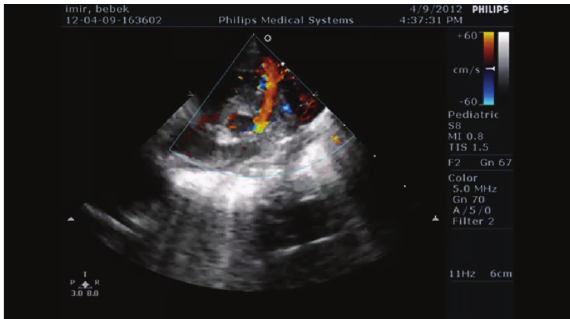
Figure 4: Postnatal echocardiographic examination demonstrating the large arteriovenous fistula connecting the left coronary artery with the apex of the right